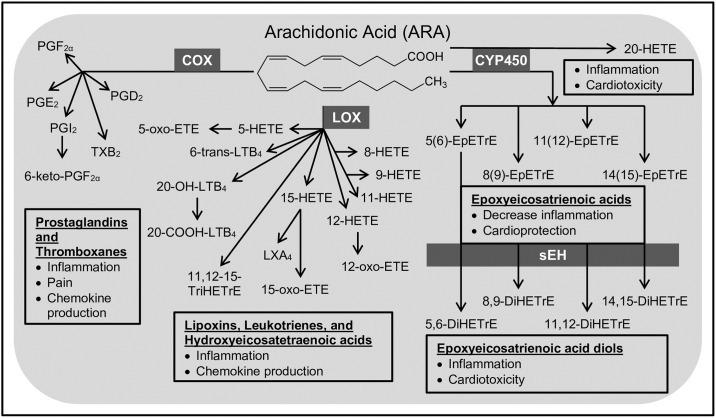
Arachidonic acid (ARA) pathway.ARA is metabolized by three enzyme families, cyclooxygenase (COX), lipoxygenase (LOX), and cytochrome P450 (CYP450), to produce numerous bioactive metabolites called oxylipins. Enzymes are shown in grey boxes. Oxylipin class and biological activity are outlined in black below the oxylipins they represent. The COX arm produces prostaglandins and thromboxanes that are pro-inflammatory, can cause pain, and can stimulate chemokine production. The LOX arm produces lipoxins, leukotrienes, and hydroxyeicosatetraenoic acids that are also pro-inflammatory and can stimulate chemokine production, with the exception of LXA4 which is anti-inflammatory. The CYP450 arm produces epoxyeicosatrienoic acids that decrease inflammation and are cardioprotective; however, these oxylipins are quickly metabolized by soluble epoxide hydrolase (sEH) to produce epoxyeicosatrienoic acid diols that are pro-inflammatory as well as cardiotoxic. The CYP450 arm also produces 20-hydroxyeicosatetraenoic acid (20-HETE), which is pro-inflammatory and cardiotoxic. Only oxylipins from the ARA pathway that were quantified on our analytical platform are depicted, excluding THF diol which is produced from multiple epoxyeicosatrienoic acids.